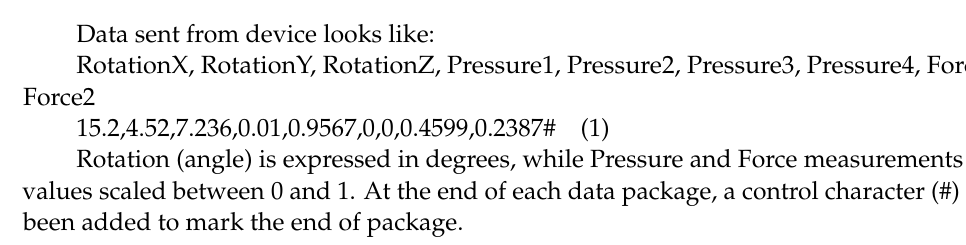
Figure 5. UML communication diagram. Server is running in multithread. Main thread communicates with Arduino, and one thread runs for each client.